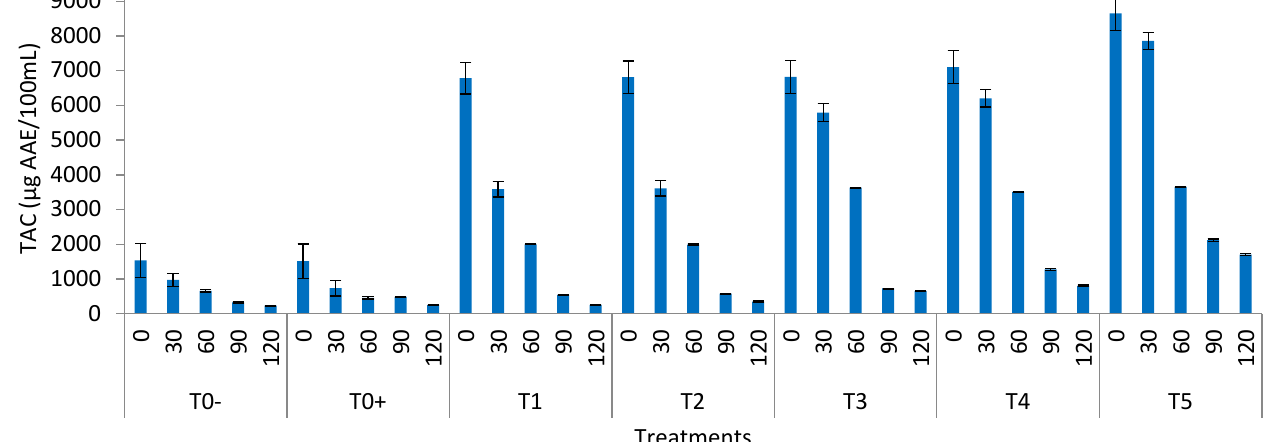
Figure 2. Total antioxidant capacity (TAC) of the watermelon juice (T 0 − = control (watermelon juice with no preservative and treatment); T 0+ = control (watermelon juice preserved with KMS); T 1 = 2 min ultrasound & 2 min microwave; T 2 = 4 min ultrasound & 1 min 50 s microwave; T 3 = 6 min ultrasound & 1 min 50 s microwave; T 4 = 8 min ultrasound & 1 min 50 s microwave; T 5 = 10 min ultrasound & 1 min 50 s) during